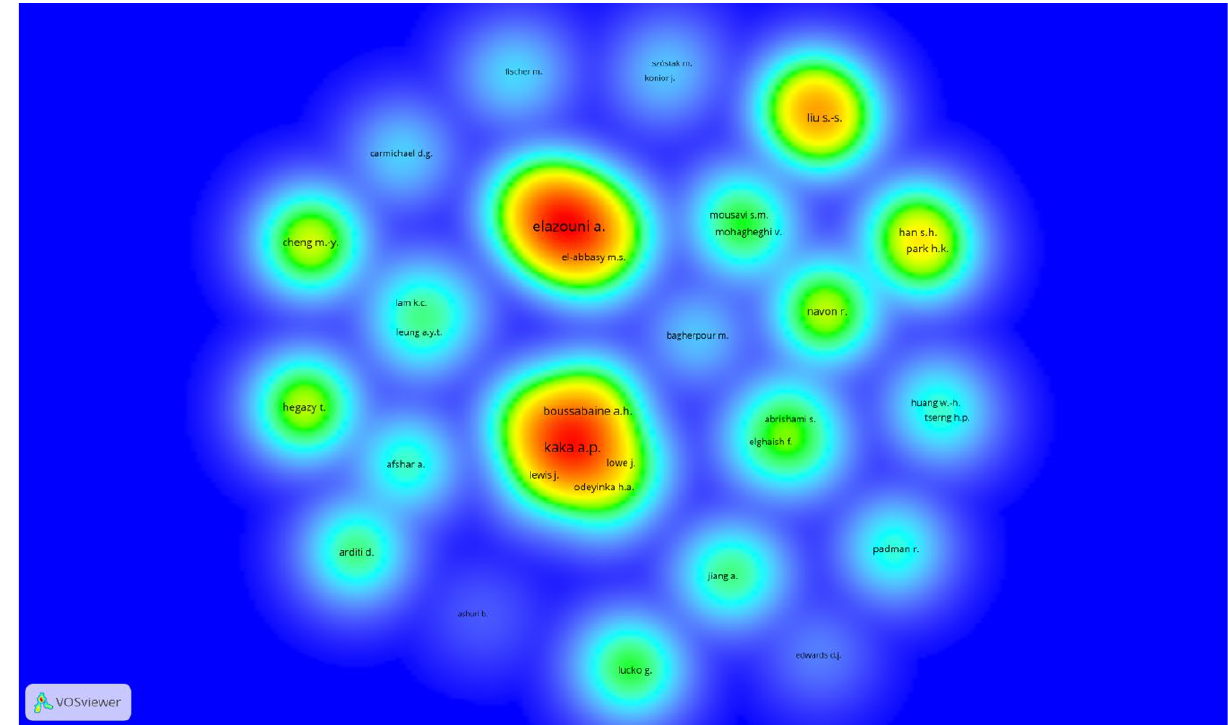
Figure 4. Density map of co-authorship network in cash flow research .